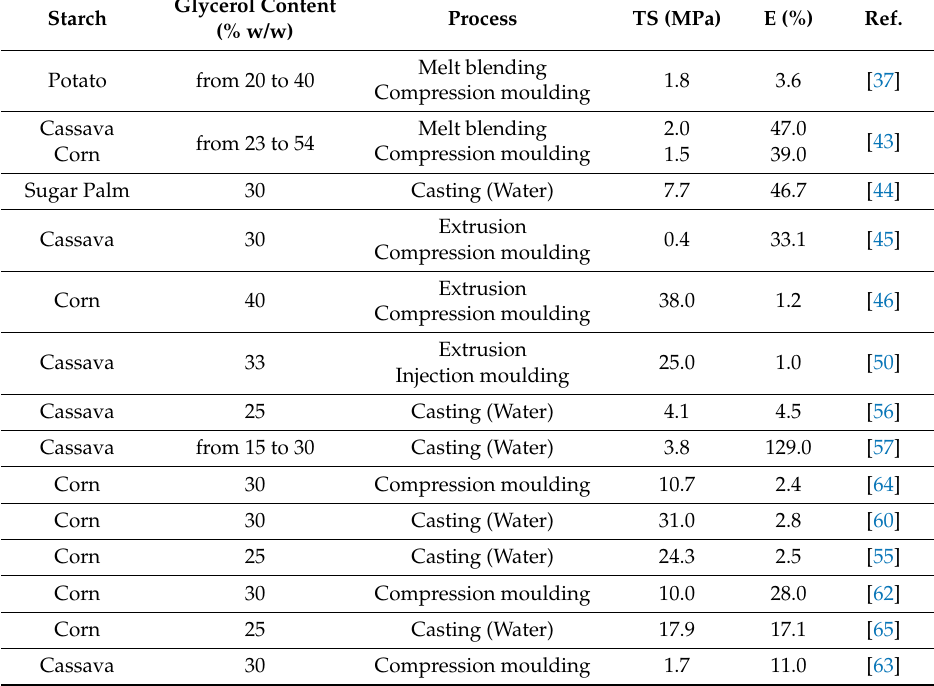
Table 3. Tensile properties of neat starch films reported by different authors. Tensile strength (MPa) and Elongation at break (%). Glycerol Content Starch (% w/w)